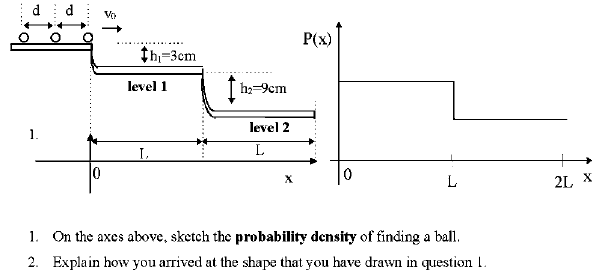
FIG. 8. “Ball on ramps” probability density question. Students answered this question on the final examination. A correct graph is shown on